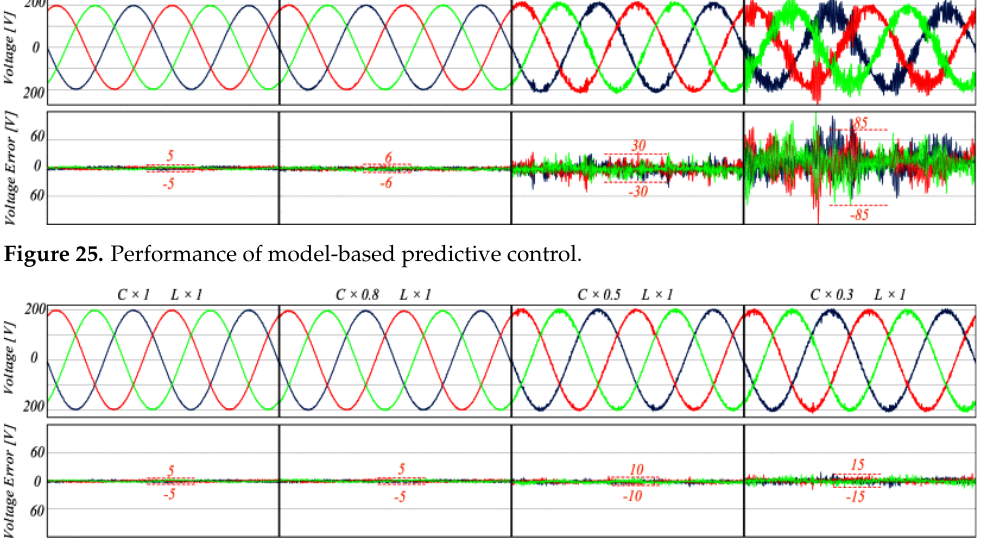
Figure 26. Performance of model-free predictive control.